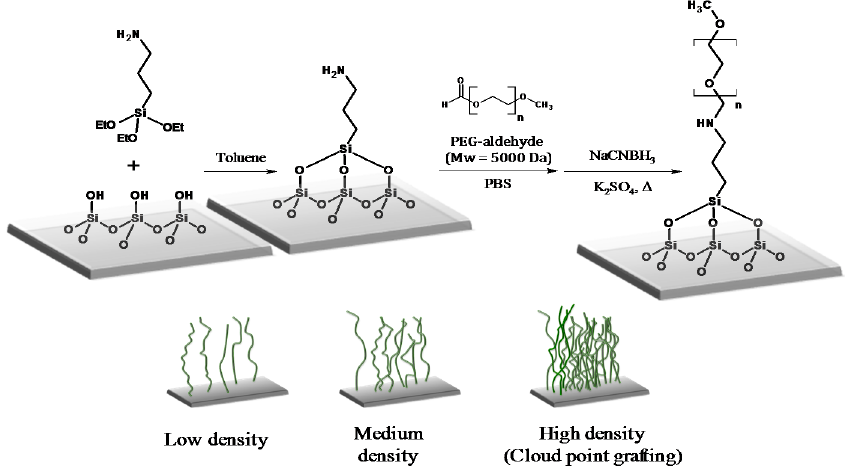
Figure 1. PEG-aldehyde grafting onto APTES modified silicon wafers.